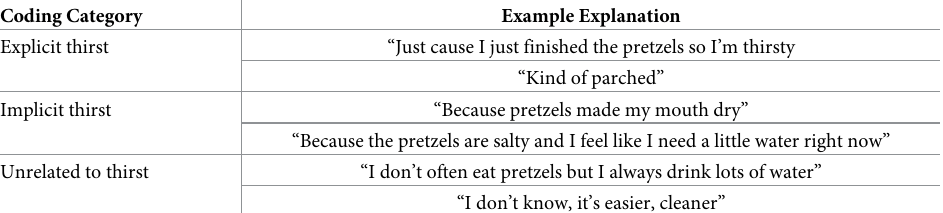
Table 1. Future preference choice explanation examples by coding